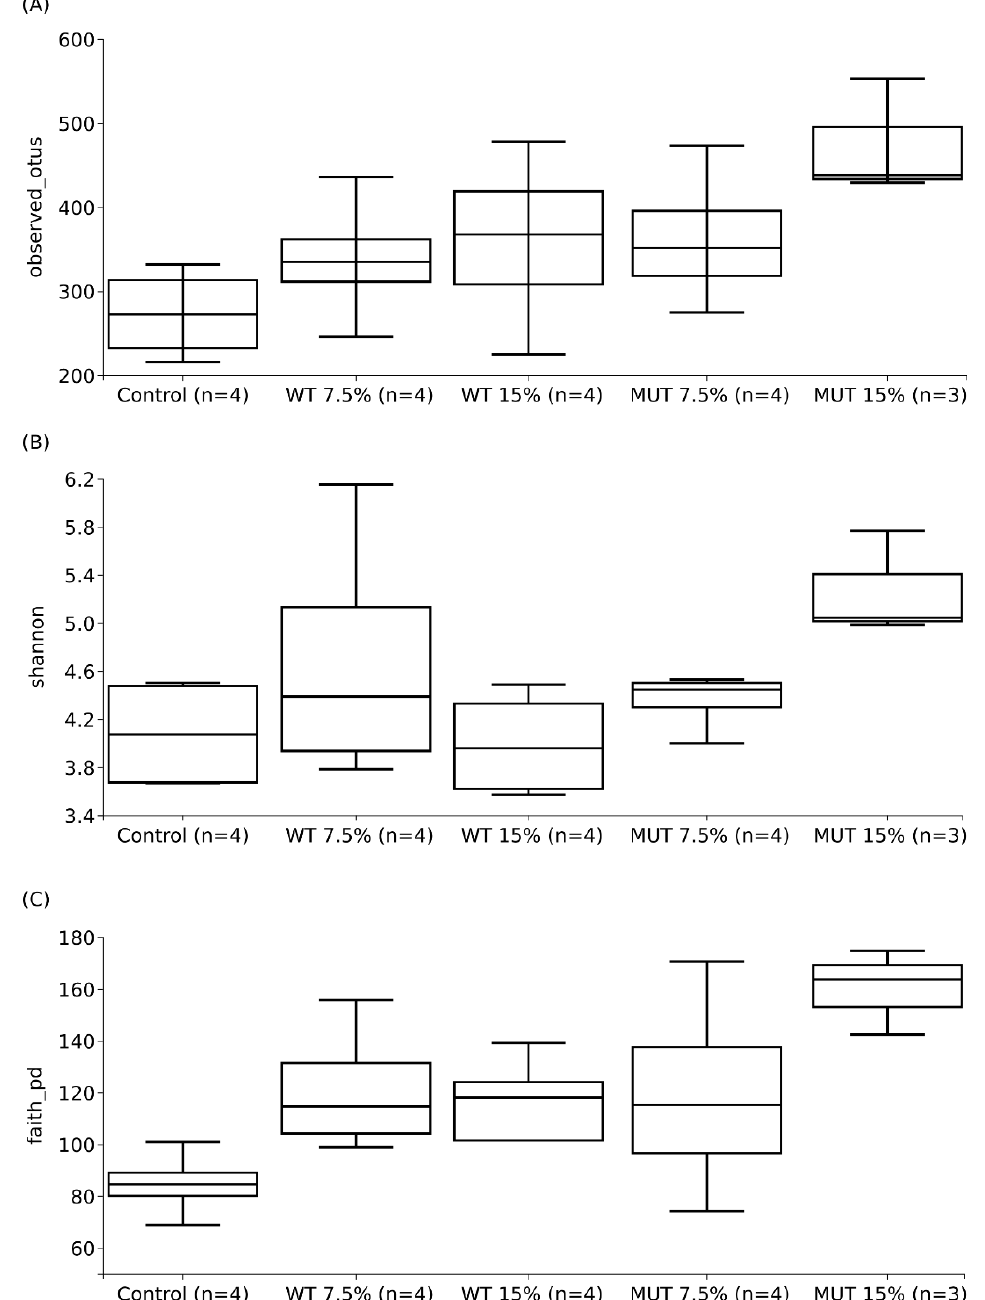
Figure 6. Average microbial diversity indices of ( A ) the observed number of operational taxonomic units (OTUs), ( B ) Shannon diversity, and ( C ) Faith’s phylogenetic diversity, for different diets (control, WT 15%, WT 7.5%, MUT 15%, and MUT 7.5%) and their standard deviations. The number ( n ) on the x -axis indicates total experimental replicates; each experimental replicate is a composite of guts from five individual fish. Control, nonsupplemented diet; WT, diet supplemented with wild-type Lobosphaera incisa ; MUT, diet supplemented with mutant strain of L. incisa .